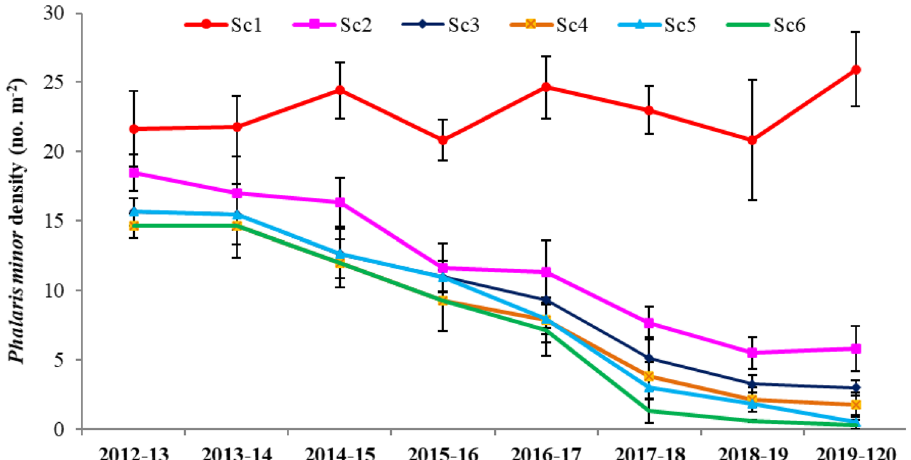
Figure 4. Phalaris minor density (no. m −2 ) influenced by climate-smart agriculture-based management practices under wheat crop. Vertical bars indicate ± SE of mean. Sc1 conventional rice–wheat system with flood irrigation (FI), Sc2 conservation agriculture (CA)-based rice–wheat–mungbean system with FI, Sc3 partial CSA-based rice–wheat–mungbean system with FI, Sc4 partial CSA-based maize–wheat–mungbean system with FI, Sc5 full CSA-based rice–wheat–mungbean system with subsurface drip irrigation (SDI), Sc6 full CSA- based maize–wheat–mungbean system with SDI. The figure has been generate using Microsoft Excell office professional Plus (2010), version